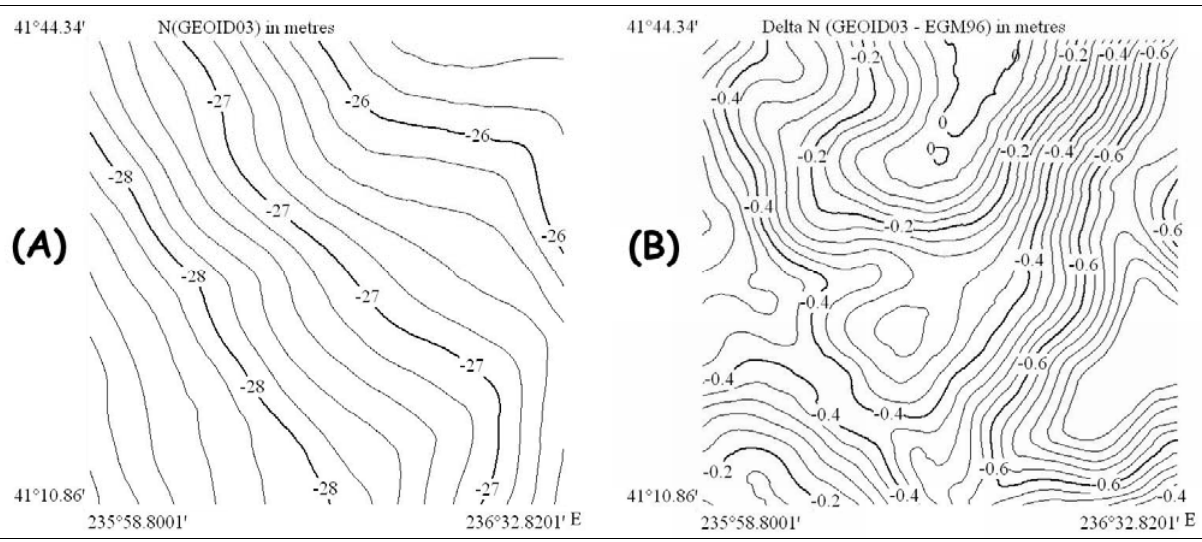
Figure 4. Geoid-related maps in the area of interest. (a) Contours of geoid heights (in metres) as computed from the US NGS GEOID03 model. (b) Differences between the GEOID03 and EGM96 geoids (in